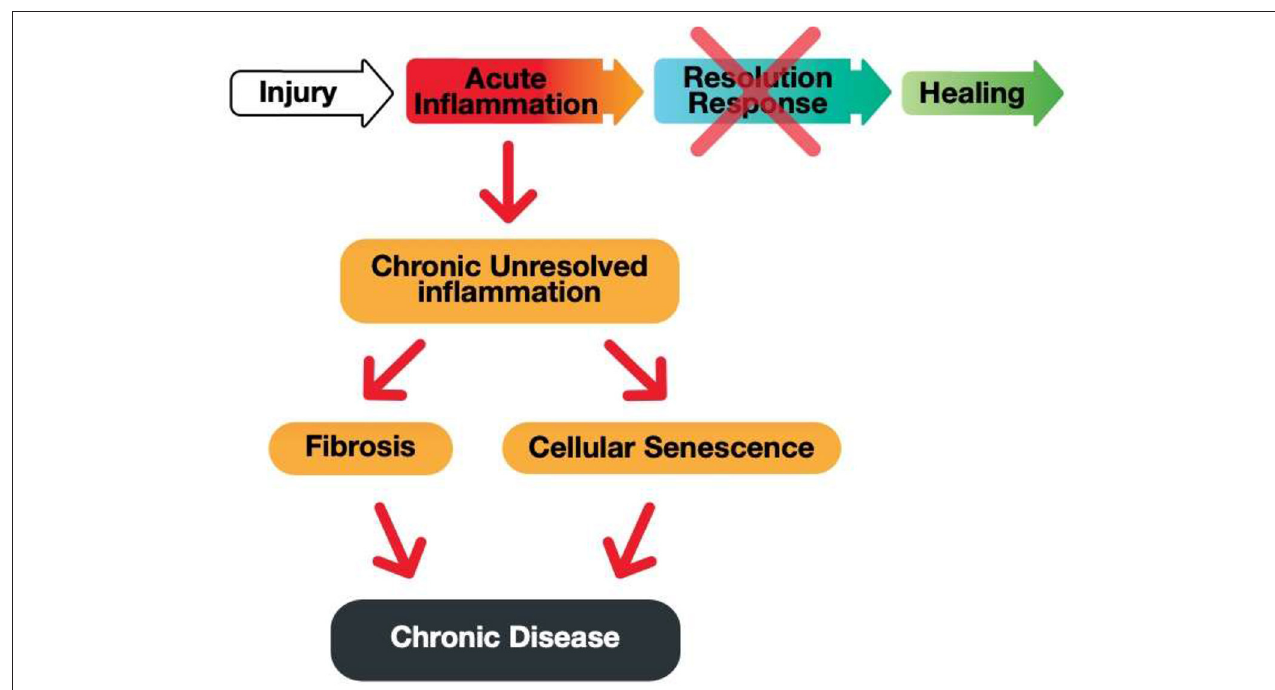
FIGURE 3 | A graphic illustration of the consequences of a blocked Resolution Response preventing healing of an injury-induced inflammation.